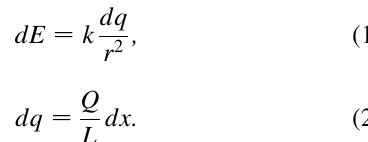
FIG. 1 (color online). Electric field problem.